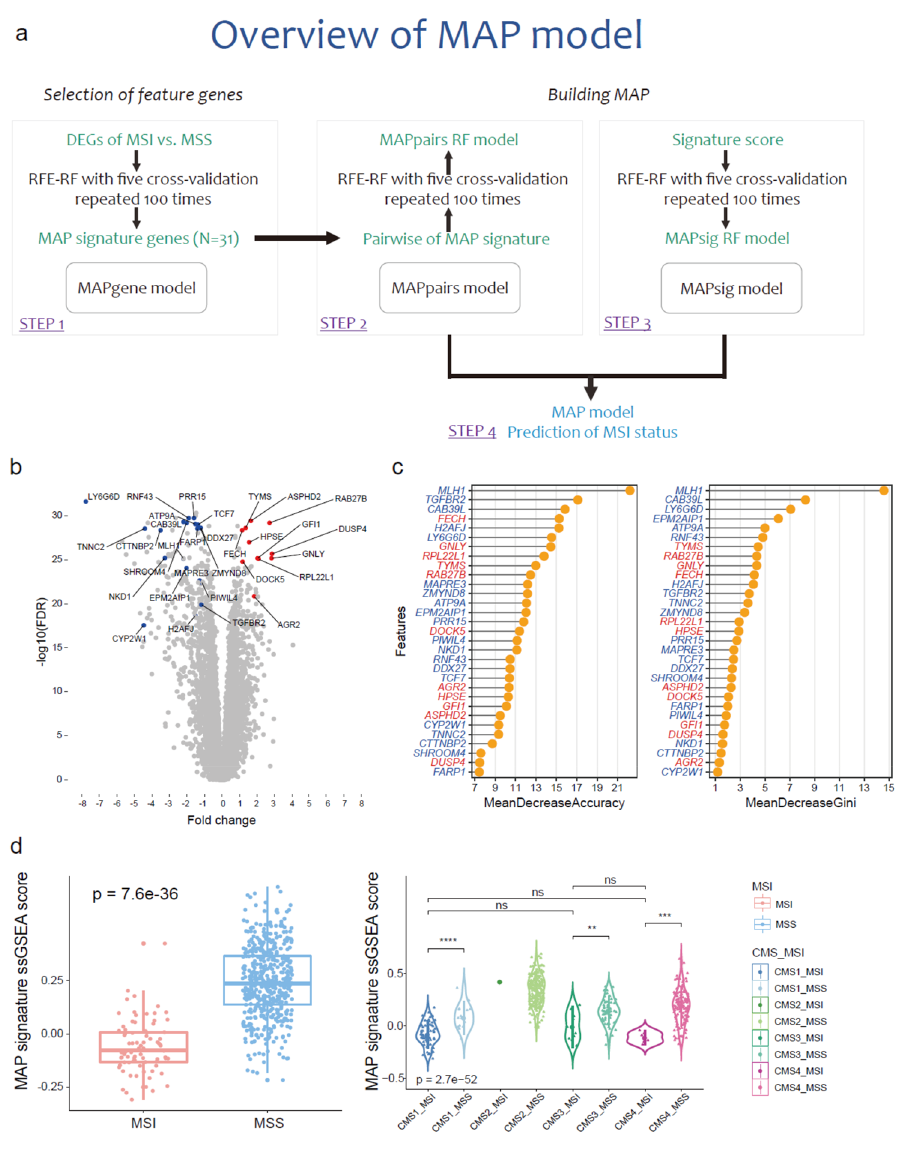
Figure 1. Overview of the MAP model and designing the MAP signature from RFE-RF analysis of gene expression data. ( a ) Overview of the MAP model. MAP was developed through a workflow consisting of four strategies. (1) identification of the MAP signature (MAPgene model); (2) modeling based on pairwise gene expression of the MAP signature genes (MAPpairs model); (3) modeling based on ssGSEA scores of cancer-, molecular-, TME-, and immune-related signatures (MAPsig model); and (4) post-refinement of the final model and prediction of MSI status. ( b ) A volcano plot for DEGs between MSI and MSS samples. The x axis represents log 2 fold changes in gene expression data for MSI versus MSS samples. Colored dots are significant DEGs in MAP signature; red and blue indicate up- and downregulated genes, respectively. ( c ) The importance of 31 features is based on accuracy and Gini index scores. The mean decrease in accuracy is a measure of how much influence it has in improving classification accuracy. The mean decrease in Gini is a measure of how impurity can be reduced by features used when separating nodes. The genes with red and blue colors indicate up- and downregulated genes in MSI, compared with MSS, respectively. ( d ) MAP signature. A box-plot of MAP signature ssGSEA scores according to MSI status (left) and CMS-MSI and MSS subtypes (right). The dots represent samples. MAP signature scores differ significantly between MSI and MSS samples independent of CMS subtypes. CMS2-MSI did not confirm statistical significance because the number of samples was small. * P < 0.05, ** P < 0.01, *** P < 0.005. DEG; differentially expressed gene, MSI; microsatellite instability, MSS; microsatellite stability, RFE-RF; recursive feature elimination-random forest, CMS; consensus molecular subtype, ssGSEA; single-sample gene set enrichment analysis, FDR; false discovery